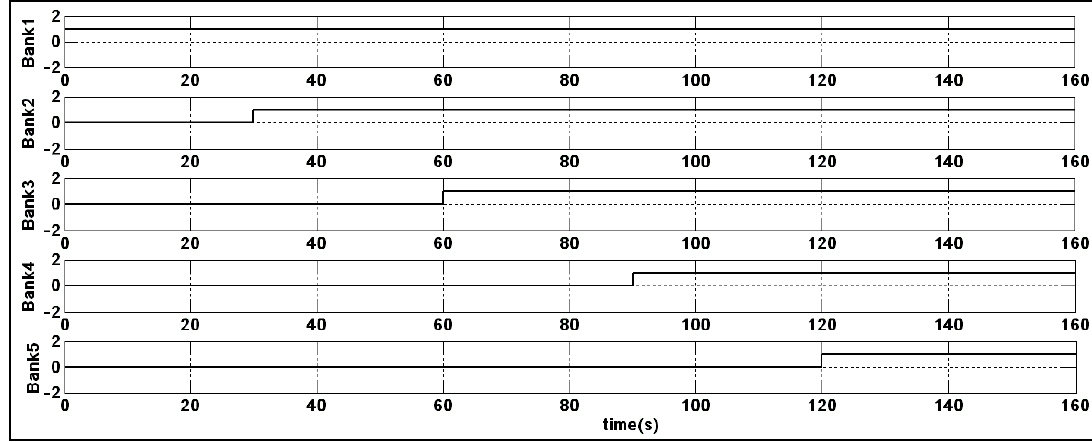
Figure 10. Variable load banks.